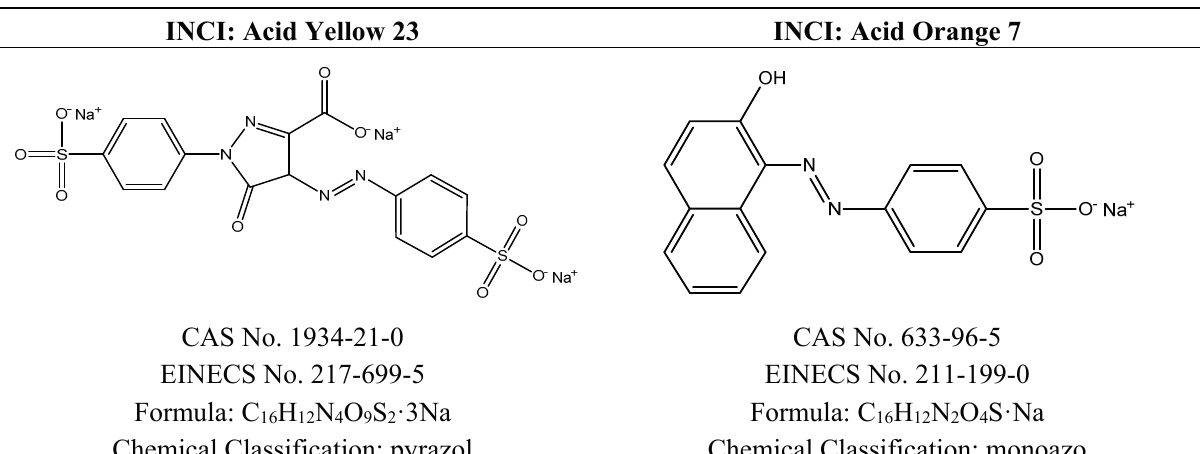
Table 1. Structural and molecular formulas of acid dyes used in temporary non-oxidative dye formulation [23]. Legend: INCI, International Nomenclature of Cosmetic Ingredients; CAS, Chemical Abstract